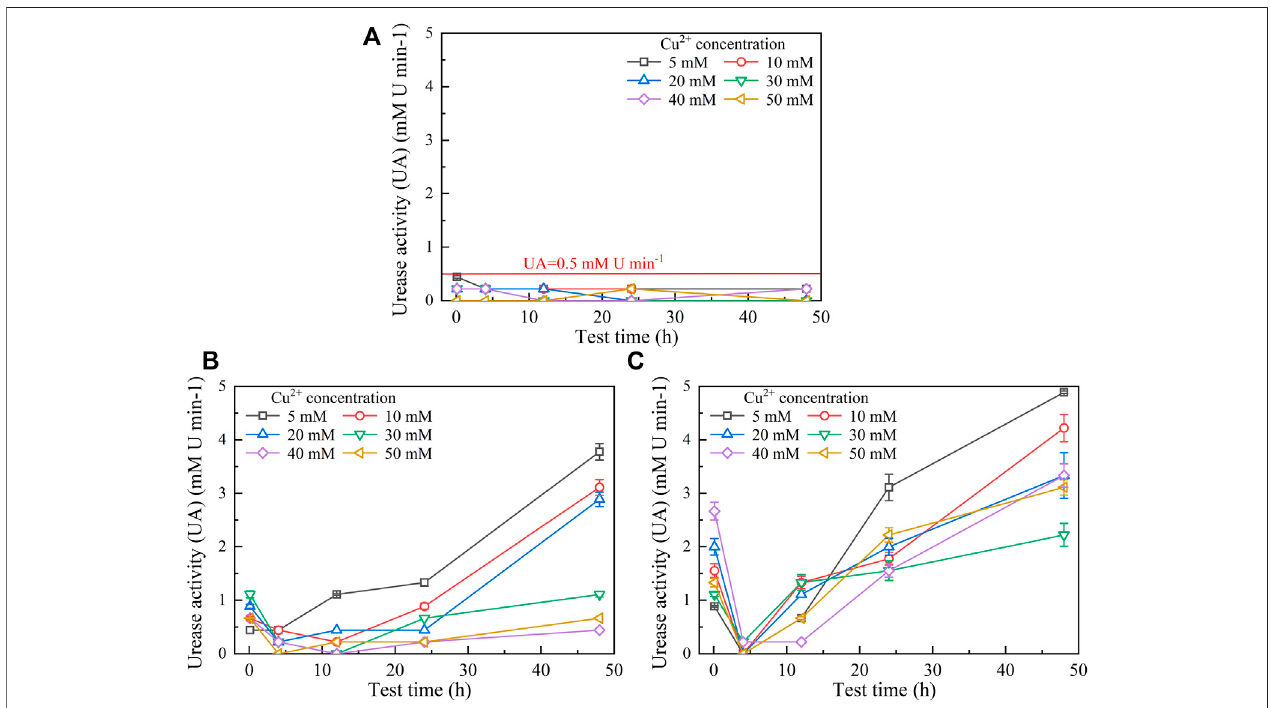
FIGURE2| TemporalrelationshipsofpHagainstPb(NO 3 ) 2 concentrations: (A) withoutyeastextractandCaCl 2 , (B) undertheeffectofyeastextract,and (C) under the effect of yeast extract and CaCl 2 addition.